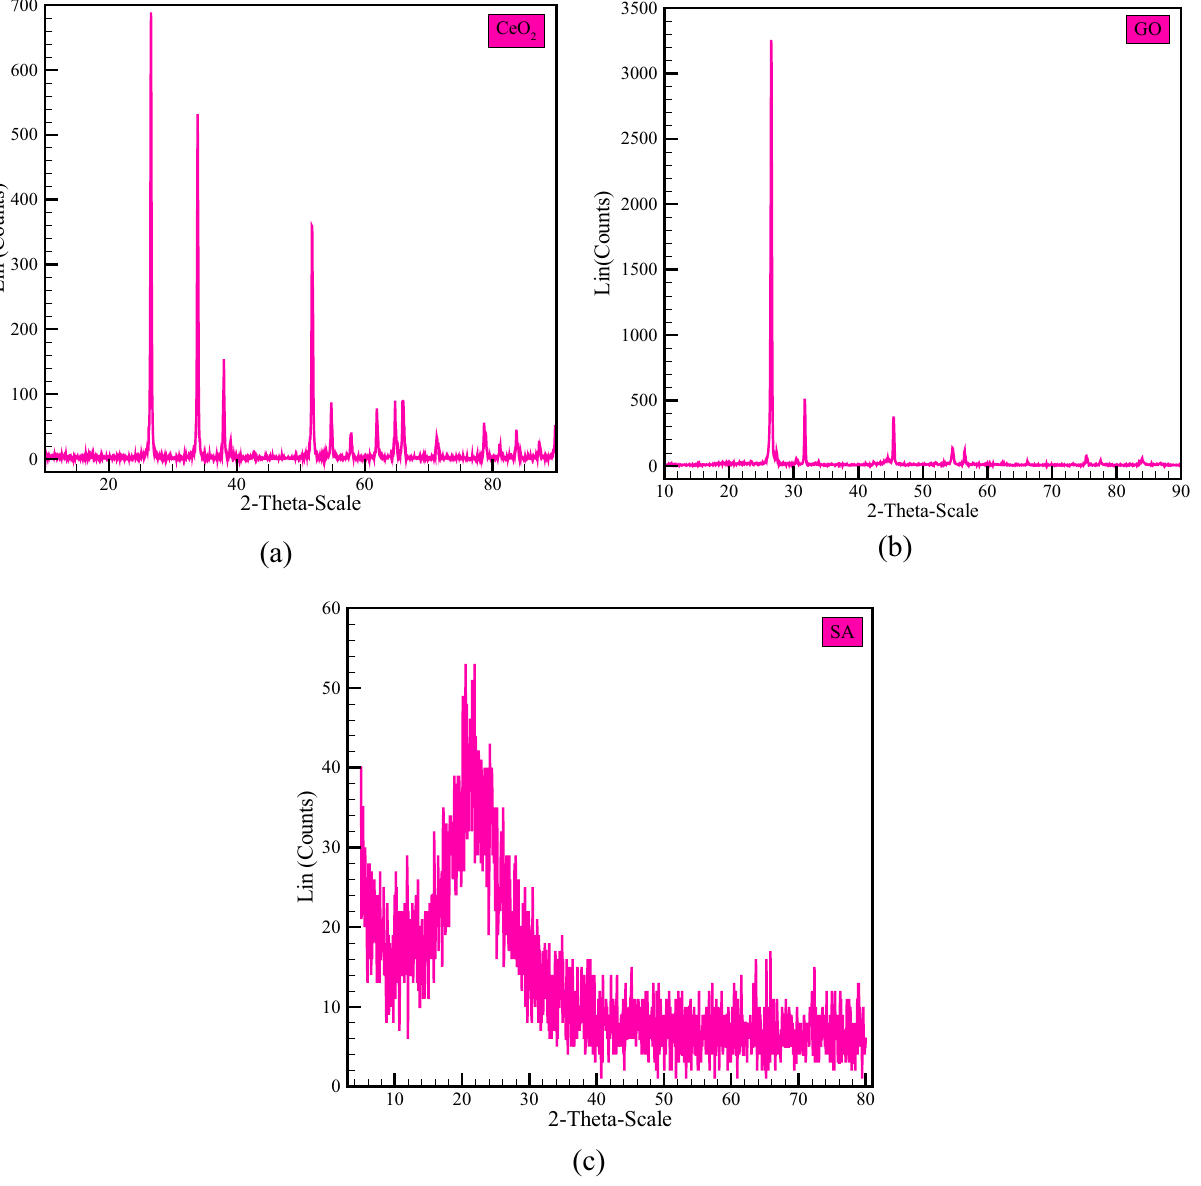
Figure 2. XRD graph: ( a ) cerium oxide, ( b ) graphene oxide and ( c ) silica